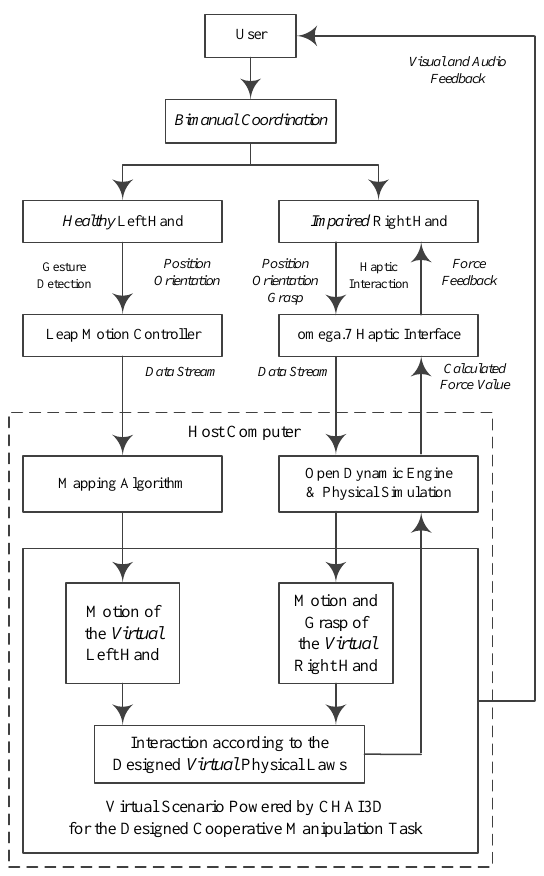
Figure 3. The paradigm of the bilateral arm rehabilitation